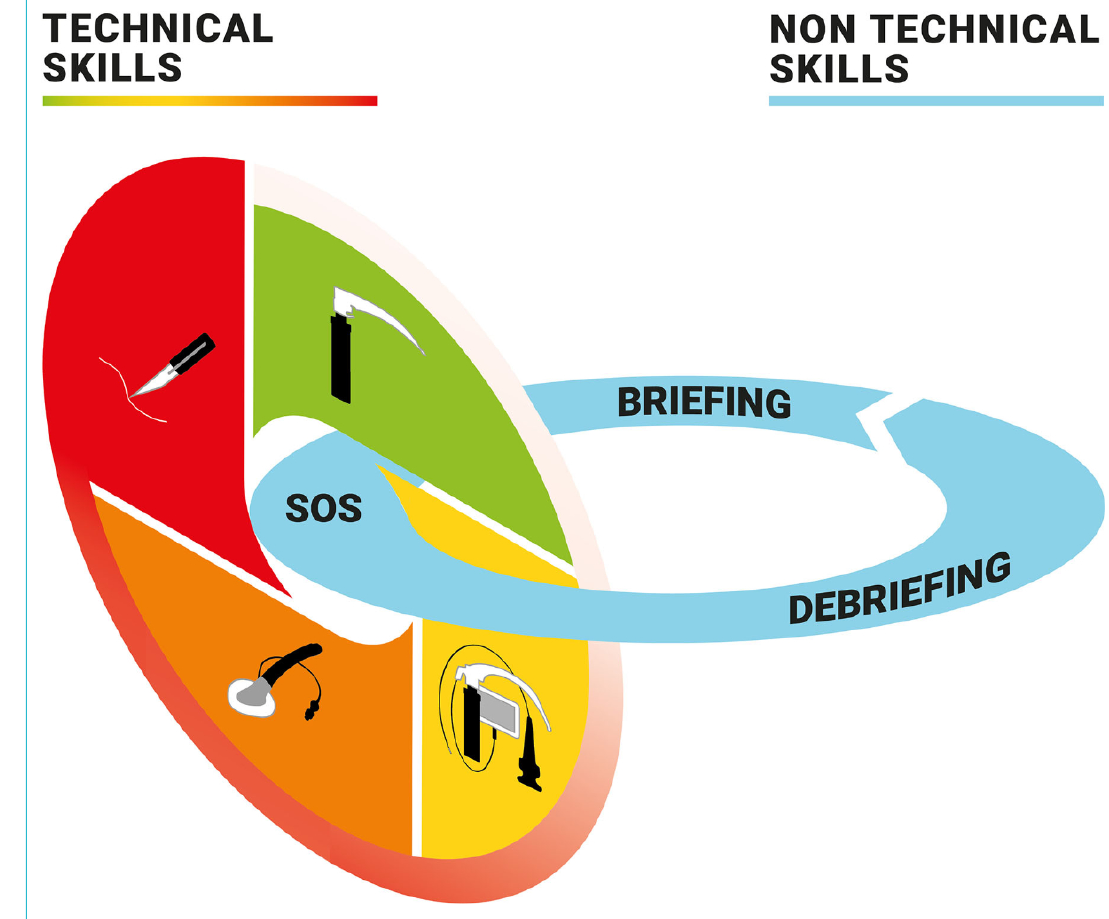
Figure 6: Graphic representation of the 2022 FLAGs with combined technical and non-technical